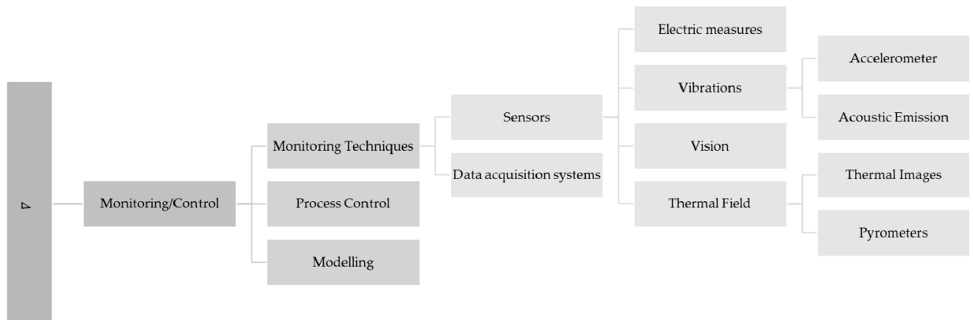
Figure A3. Technologies’ classification: Auxiliary-related branch.